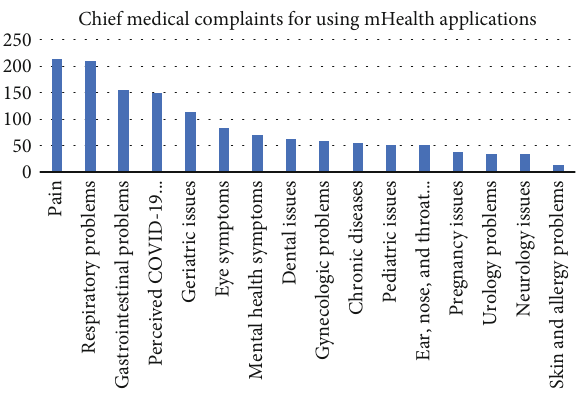
Figure 4: Chief medical complaints about using mHealth applications. Note: Each respondent can select more than one